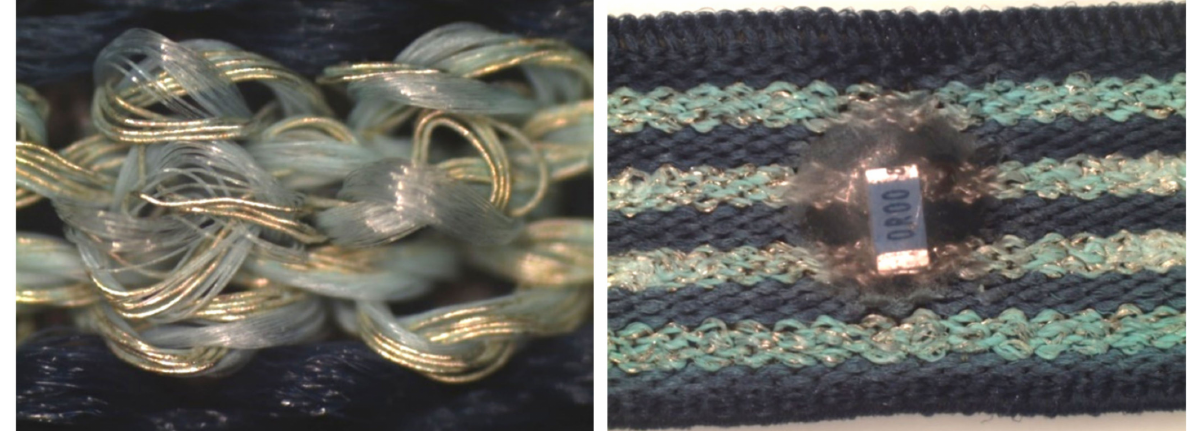
Figure 10. Details of the sample after aging by artificial sweat.